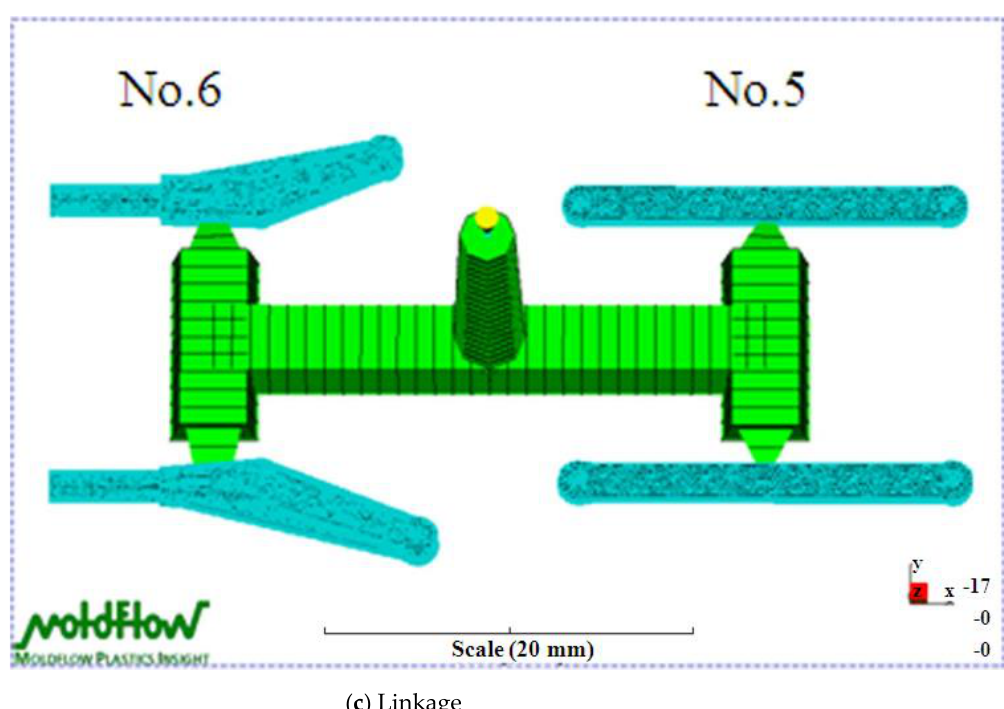
Figure 3. The meshes of Moldflow analysis on the parts of the flapping-wing MAV.